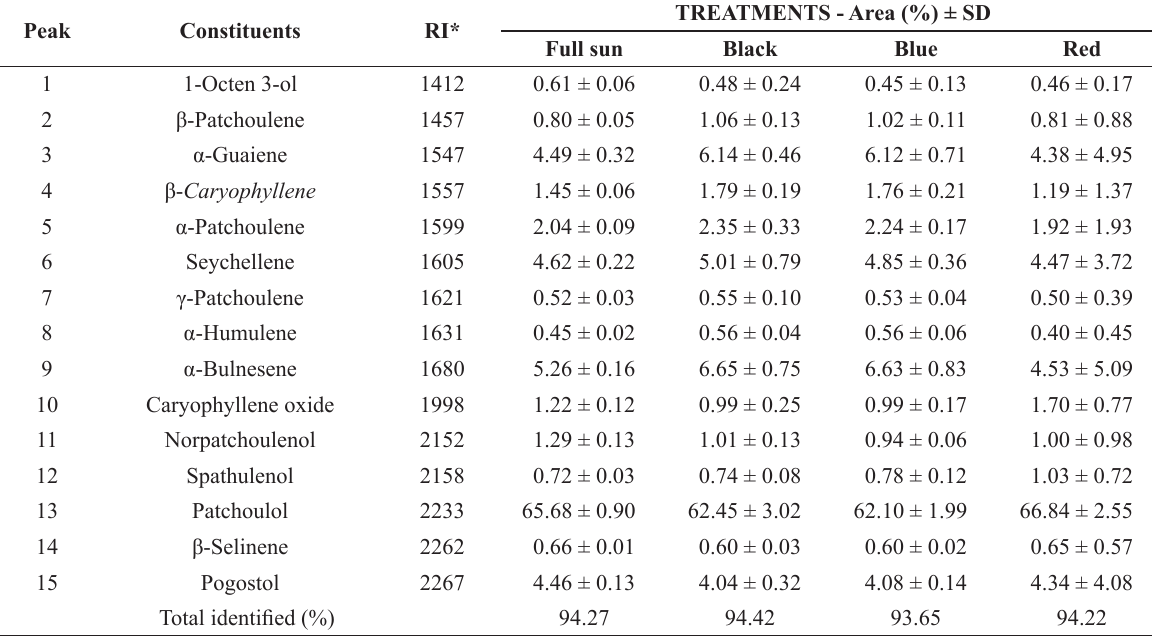
Chemical composition of the essential oil from P. cablin leaves grown under full sun and under colored shade